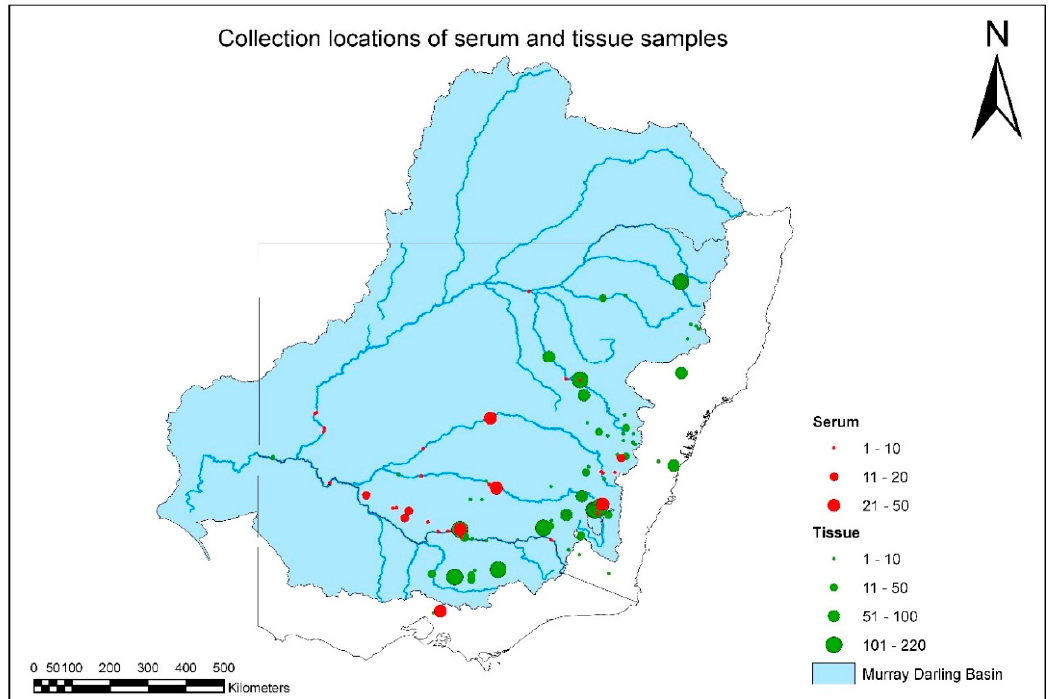
Figure 2. Distribution and number of tissue and serum samples collected from all fish species between July 2007 and June 2011.